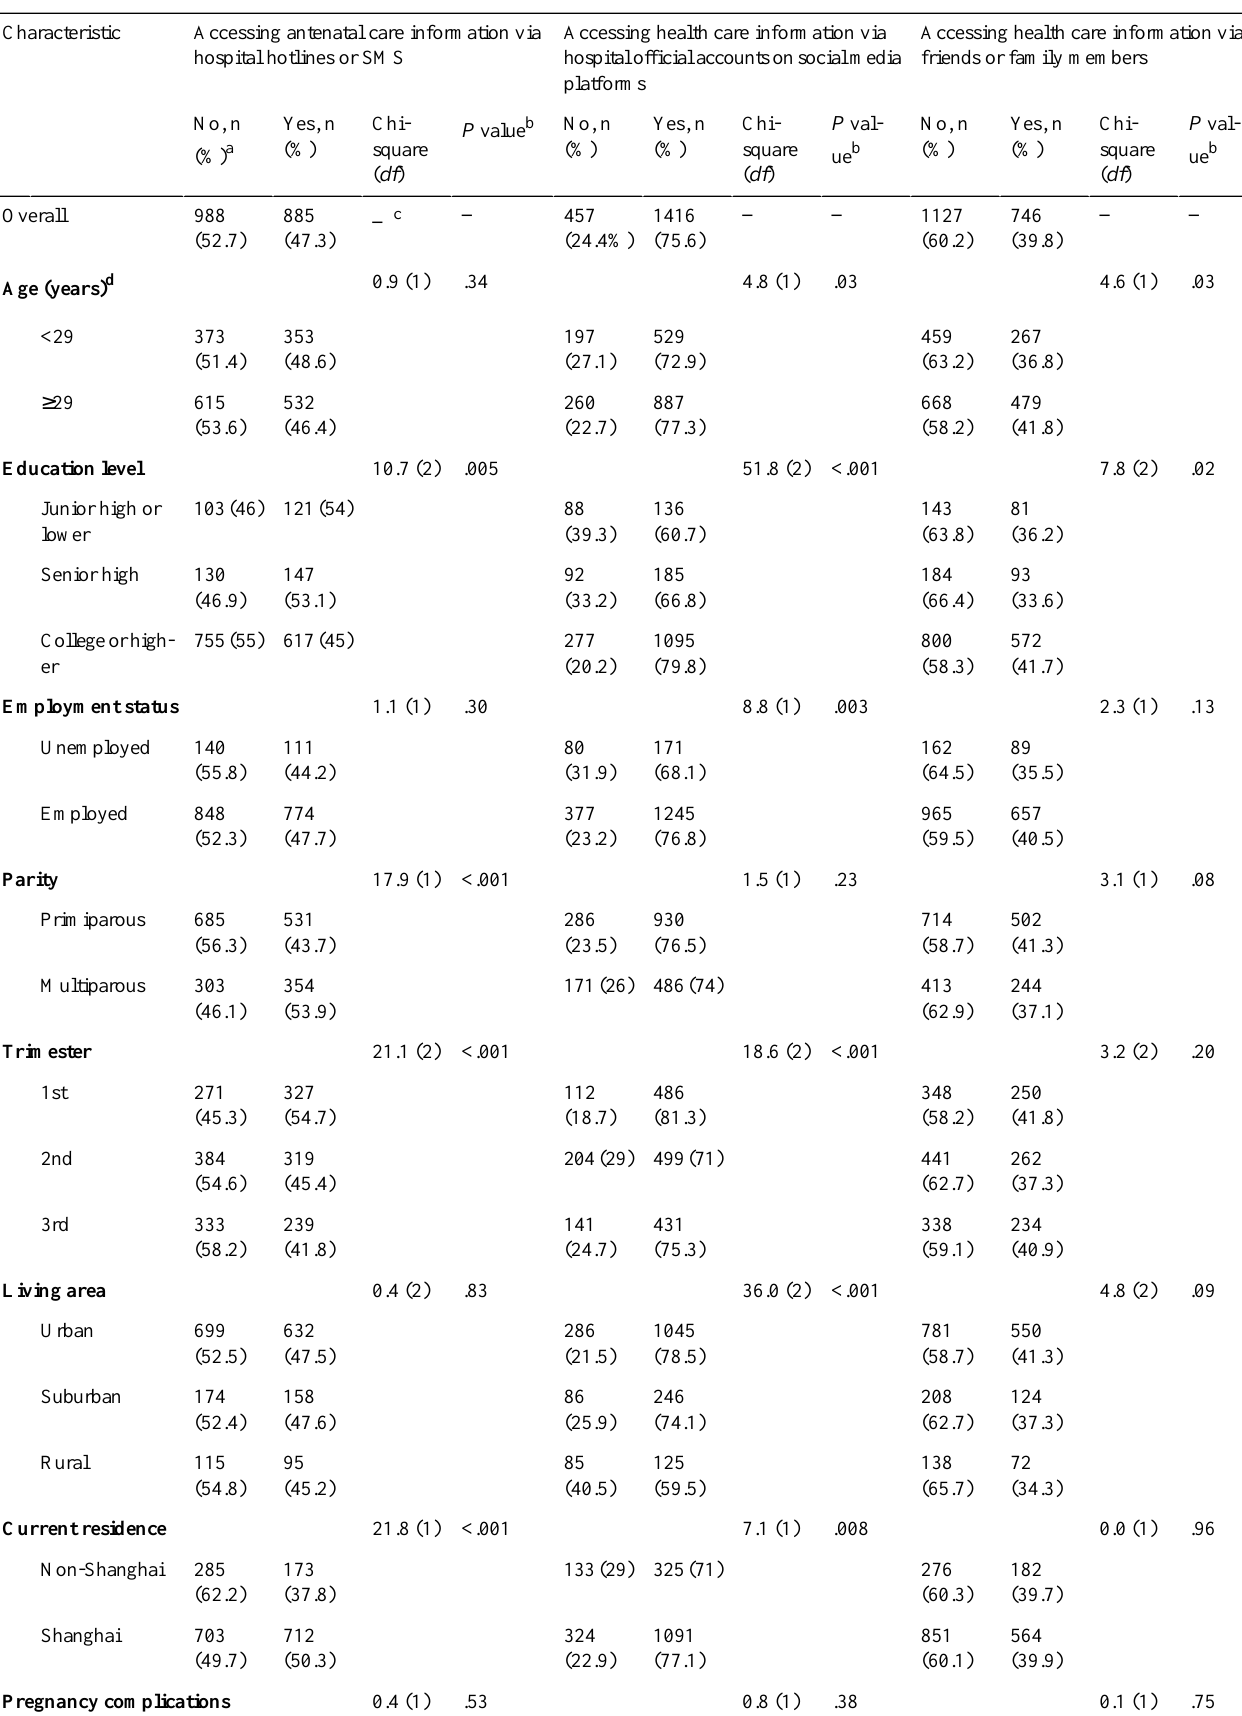
Table 1. Characteristics of pregnant women and their approaches of accessing antenatal care information during the COVID-19 outbreak in China